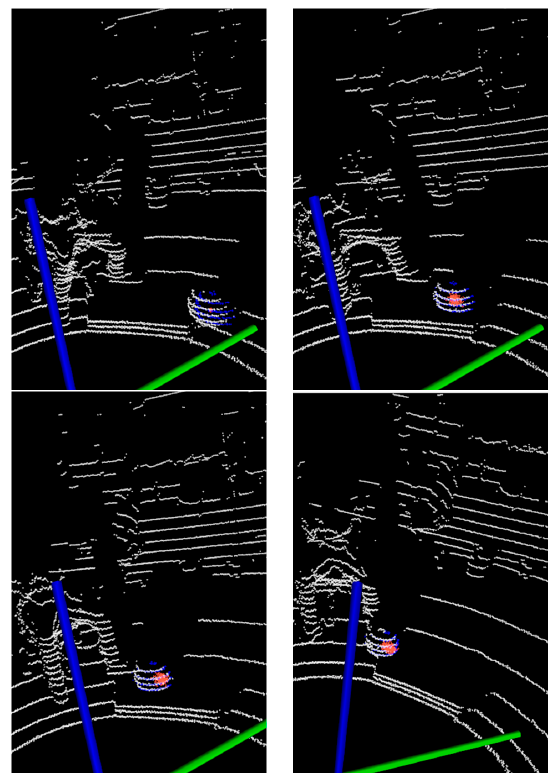
Figure 12. The tracking results with KF in occlusion scenes. Sensors 2017 , 17 , 1932